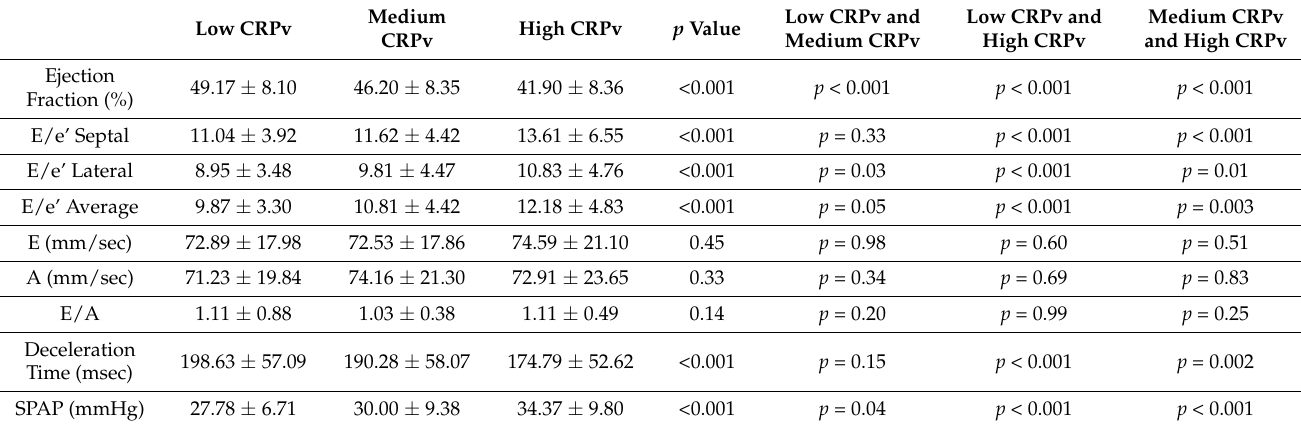
Table 2. Echocardiographic values stratified by CRPv tertiles.